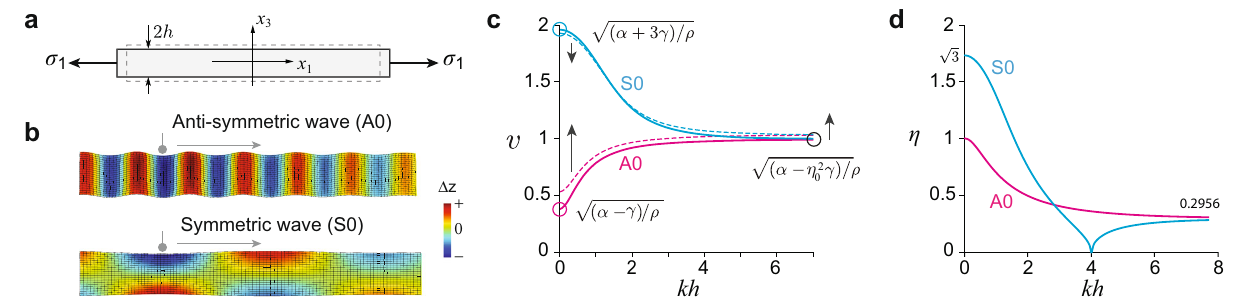
Fig. 4 Acousto-elastic effect for Lamb waves. a A thin plate with thickness 2 h put under tensile stress σ 1 along x 1 . b Modal shapes of the fundamental anti- symmetric (A0) and symmetric (S0) Lamb waves, with color-coded vertical displacement Δ z . c Dispersion curves ( kh Vs v where k is the wavenumber and v is the wave speed) for the A0 and S0 modes in a hypothetical incompressible material with initial shear modulus μ = 1.0 kPa, Landau third-order modulus A = − 6.4 kPa and mass density ρ = 1.0 g/cm 3 , subject to a uni-axial extension of 5% (stretch λ The circles indicate three asymptotic values of the dispersion curves, and arrows indicate their direction of change with tension ( α and γ are instantaneous elastic moduli, η 0 = 0.2956). d Master curves for the dispersion relation of all materials and pre-stresses/stretches (independent of ρ , μ , A , σ 1 , λ 1 ): identifying two values of η , the dimensionless variable on the vertical axis, from measurements gives access to the stress and the strain.